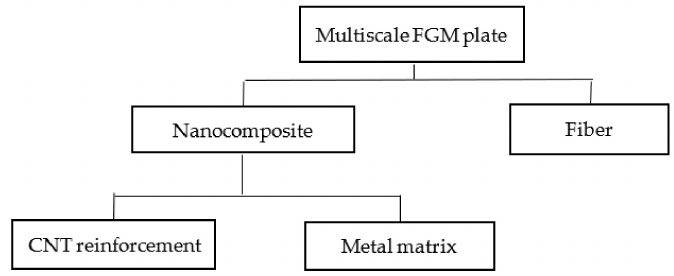
Figure 2. Hierarchy of the three-phase multiscale FGM